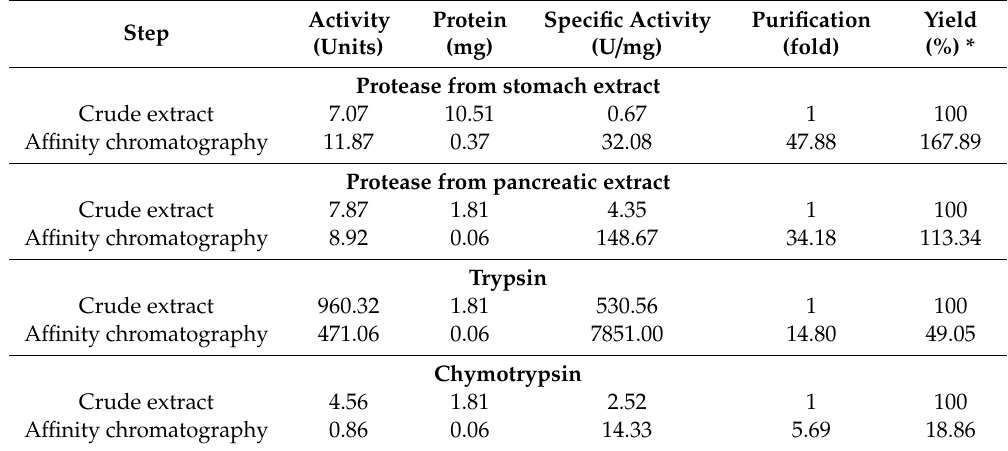
Table 4. Purification protocol for proteases from Sparus aurata (stomach and pancreas) on CB3GA- Cellulose 2